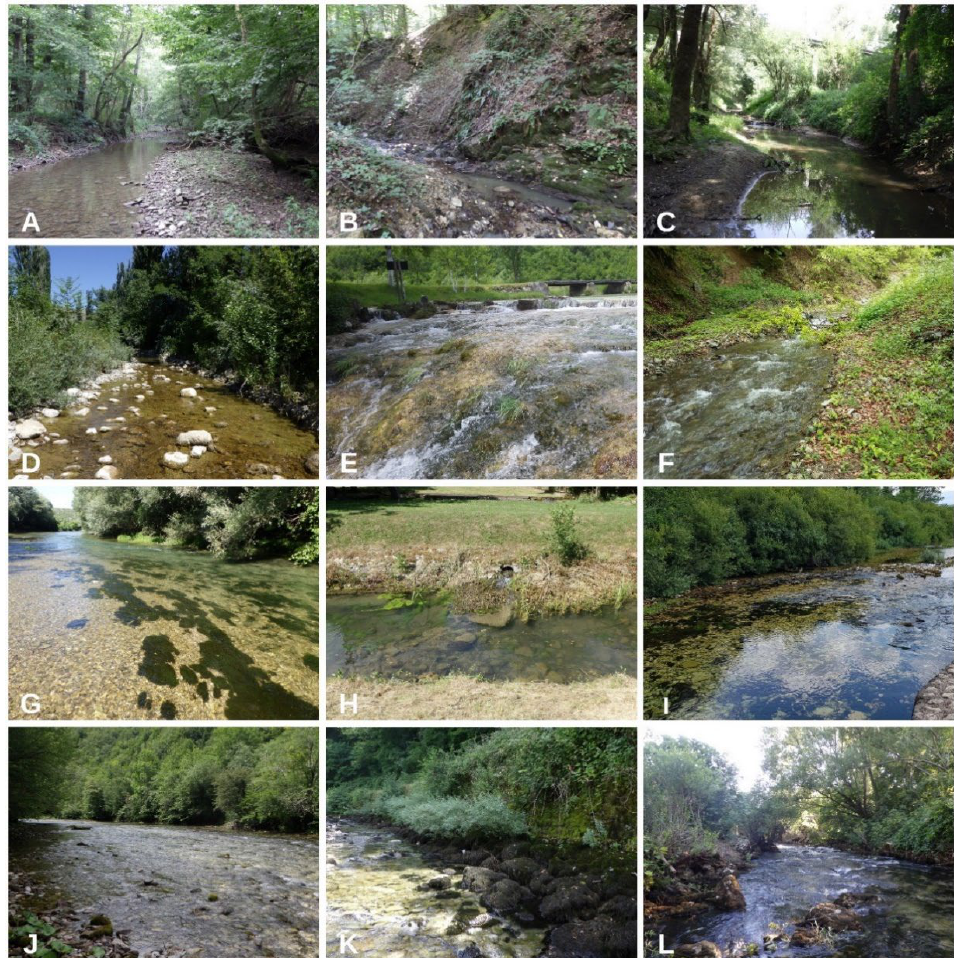
Figure 2. Examples of the sampling sites belonging to different TWINSPAN communities. Group 1: ( A ) Petrinjčica River (Miočinovići), ( B ) Vučjak River (Požega), ( C ) Kravarščica River (Dabići); Group 2: ( D ) Kobilica River (Kusac), ( E ) Korana River (settlement Korana); Group 3: ( F ) Šumetlica River (upper course); Group 4: ( G ) Krka River (Marasovine); ( H ) Joševica River (Donja Suvaja), ( I ) Cetina River (Barišići); Group 5: ( J ) Kupa (Kupari), ( K ) Rječina (Kukuljani), ( L ) Krupa (Mandići). The characteristic species of Group 1 ( Oxyrrhynchium hians–Chiloscyphus pallescens community) (Appendix A) were mostly hygrophytic species confined to periodically submerged river margins, such as the mosses Oxyrrhynchium hians , Plagiomnium undulatum, Pohlia melanodon , and the liverworts Chiloscyphus pallescens , Pellia neesiana , Conocephalum salebrosum , along with the moss Dichodontium pellucidum , collected from periodically submerged rocks within the riverbeds. However, the constant species included rheophytes such as Rhynchostegium riparioides and Leptodictyum riparium , as well as an ampyphyte, Cratoneuron filicinum . The hygrophytes Didymodon tophaceus , Apopellia endiviifolia and Funaria hygrometrica , as well as the amphiphyte Eucladium verticillatum and the rheophyte Fissidens crassipes , were the characteristic species of Group 2 ( Didymodon tophaceus–Apopel- lia endiviifolia community). Group 3 ( Fissidens pusillus–Veronica beccabunga community) was characterized by bryophytes such as Brachythecium rutabulum , Fissidens pusillus and Oxyrrhynchium speciosum , as well as by the vascular helophytes Veronica beccabunga and Persicaria dubia (Appendix A). In general, G roups 1, 2 and 3 were cha racterized by a higher frequency of hygrophyte bryophyte species (1– 65.9%, 2 – 44.1%, 3 – 56.3%), followed by rhe- ophytes (1– 18.7%, 2 – 37.0%, 3 – 31.3%) (Figure 3).